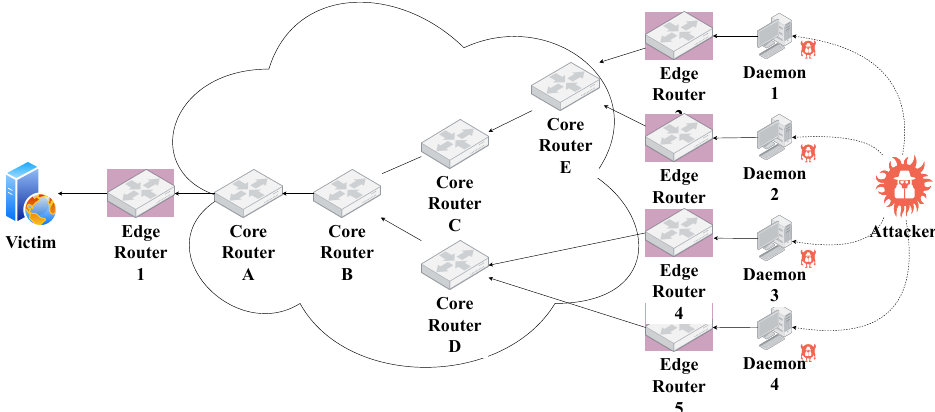
Figure 4. Partial network used in the simulation